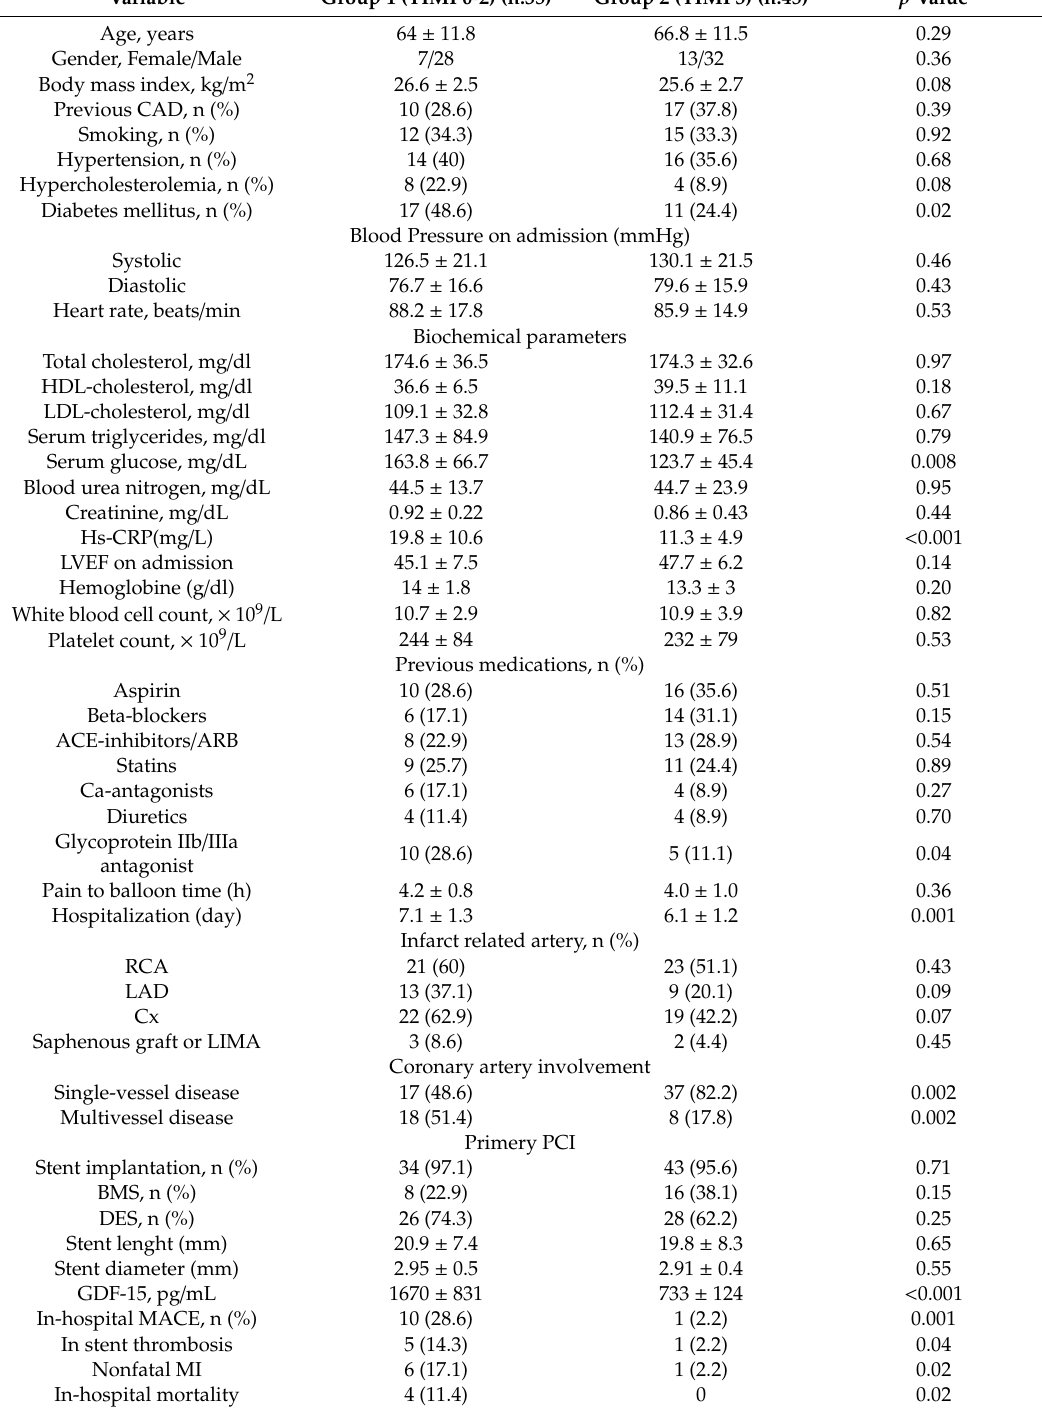
Table 1. Baseline characteristics of patients in